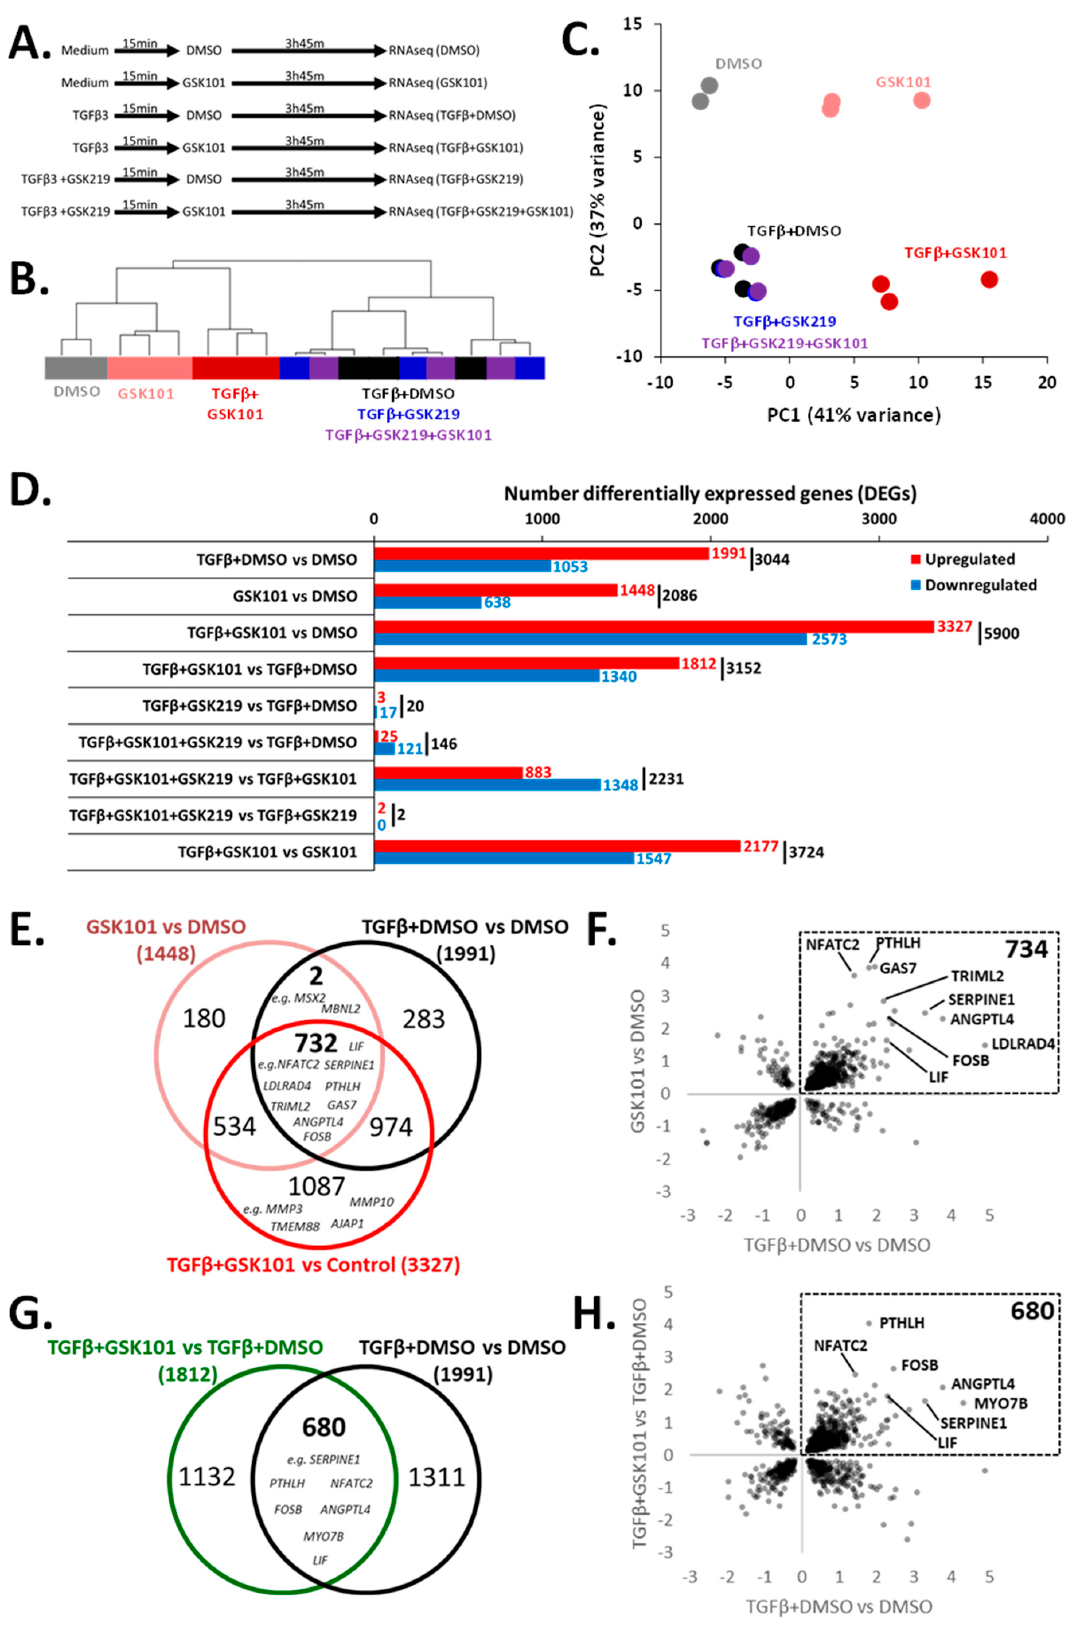
Figure 3. RNA-seq identification of TGF β 3 response genes that are enhanced by TRPV4 activation. ( A ) Experimental design for RNA-seq (triplicate). ( B ) Hierarchical clustering and ( C ) PCA analysis shows separation of DMSO, GSK101, TGF β